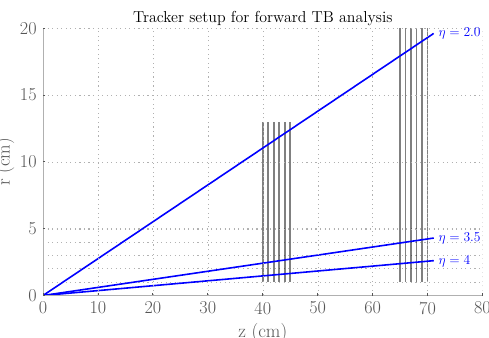
Figure 7. Sketch of the proposed forward tracker setup, consisting of two endcaps, each 5cm wide, located at z = 40 and 65 cm, providing hermetic coverage of the forward region 2 example. We assume any track reaching the far side of the near endcap has yielded su(cid:14)cient tracker hits to allow a reliable track reconstruction, and, veto on tracks traversing the far